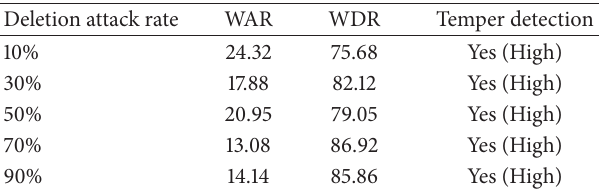
Table 3: Detection of malicious deletion of tuples with different attack rates ( 𝜂 = 10 6